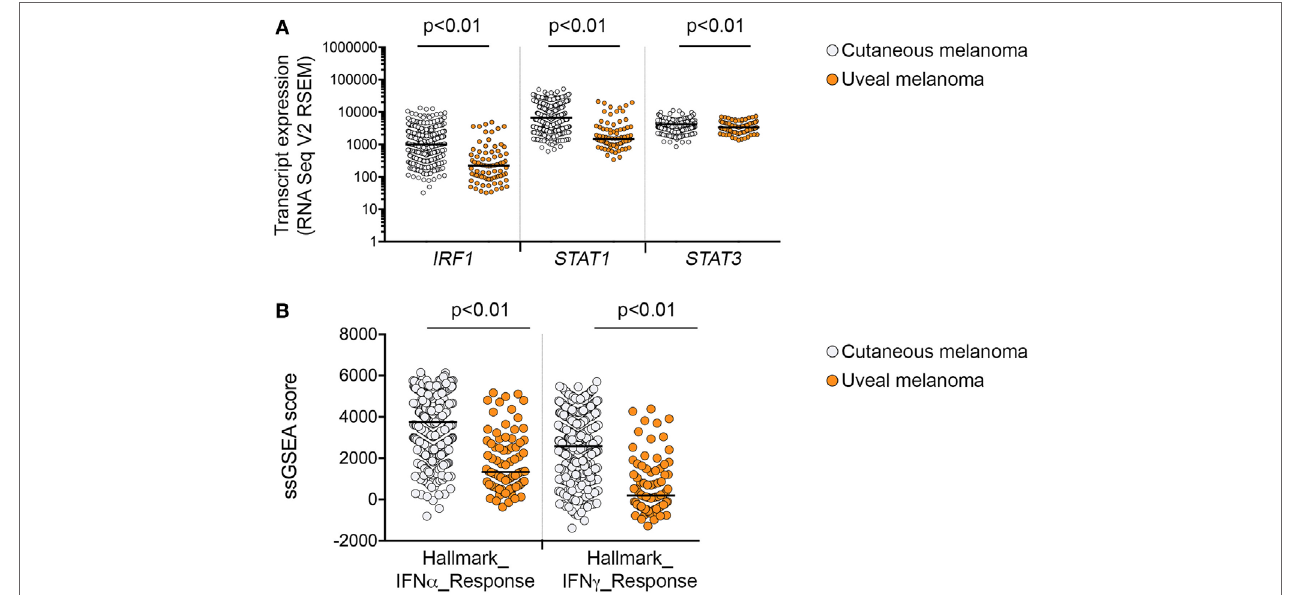
FigUre 4 | Interferon- γ signaling in cutaneous and uveal melanoma (UVM). (a) Expression of mRNA transcripts for IRF1 , STAT1 , and STAT3 in the 80 uveal [The Cancer Genome Atlas (TCGA) UVM dataset] and 472 cutaneous melanoma samples (TCGA skin cutaneous melanoma dataset). (B) Single sample gene set enrichment analysis (ssGSEA) scores for the Hallmark_interferon_alpha and Hallmark_interferon_gamma response signatures in the 80 uveal and 472 cutaneous melanoma samples from the TCGA datasets. Expression levels were compared using a nonparametric Mann–Whitney test, p values are